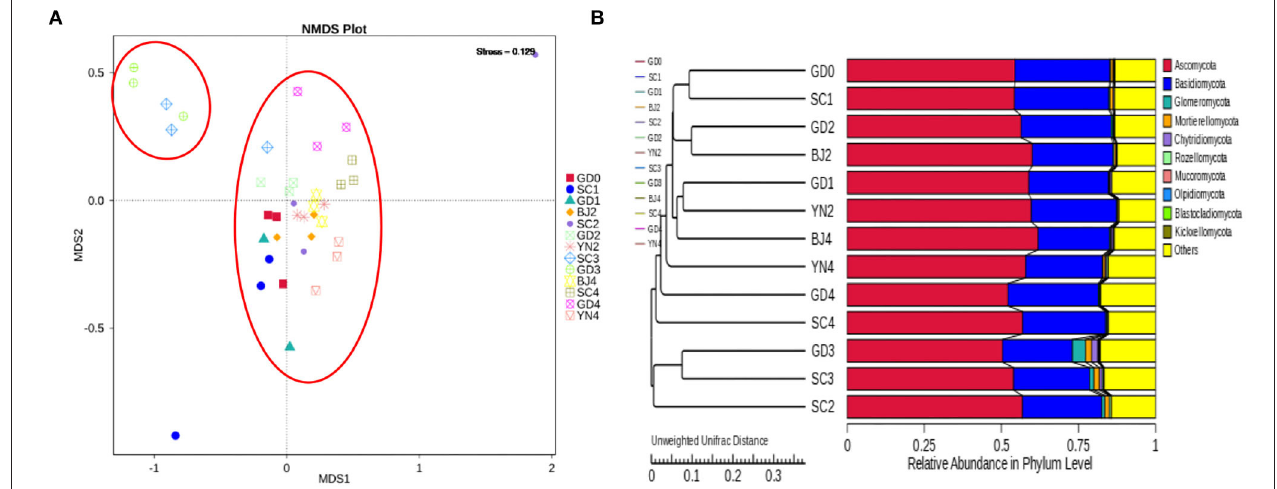
FIGURE 6 | (A) NMDS analysis of fungal community composition. Each point represents a sample, plotted by the second principal component on the Y-axis and the first principal component on the X-axis, which was colored by group. (B) UPGMA clustering tree based on weighted UniFrac distance. UPGMA clustering tree (at left). The relative phylum-level abundance map (at